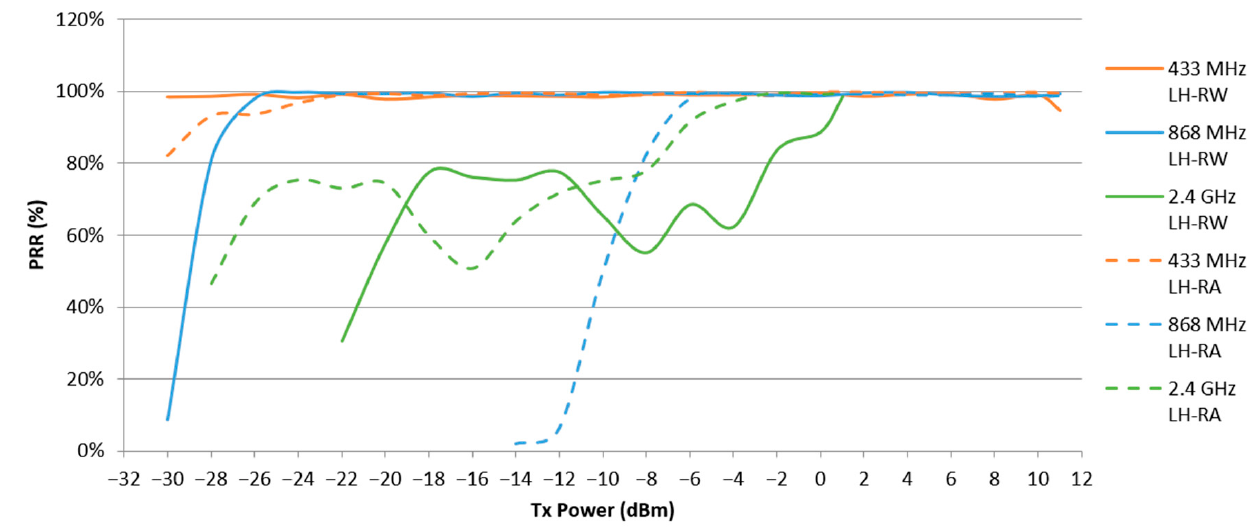
Figure 6. Packet reception rate (PRR) in the standing scenario.